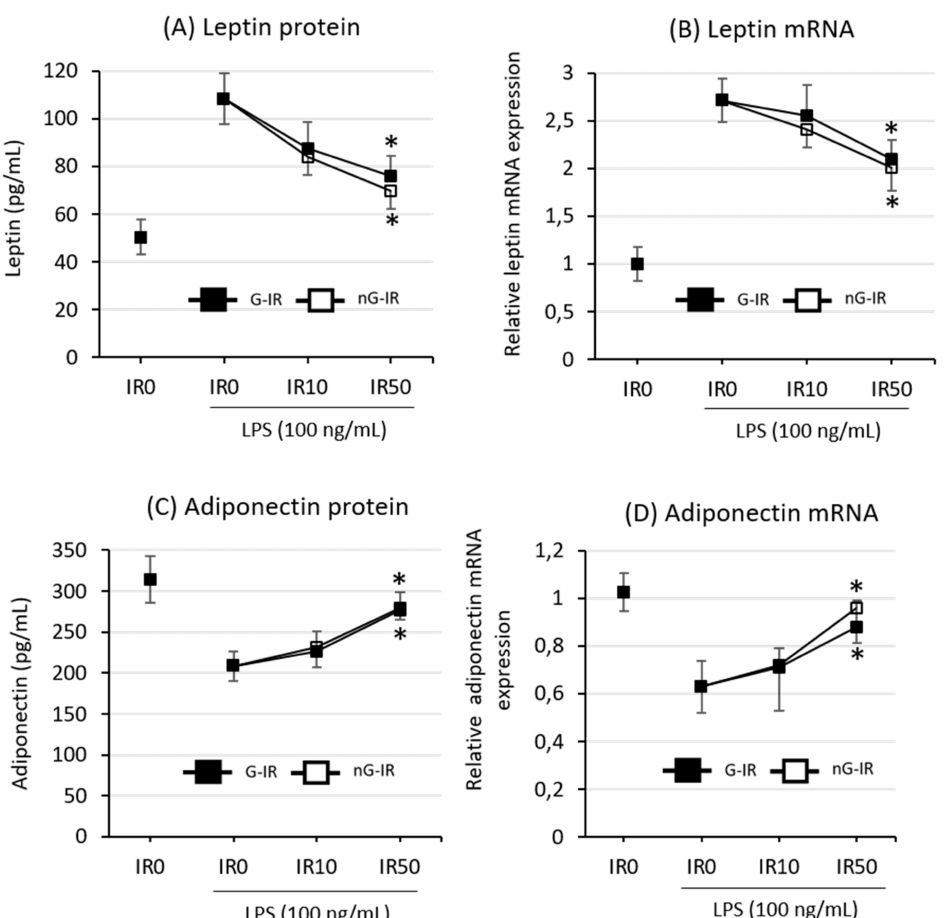
Figure 3. E ff ects of various forms of irisin (glycosylated (G-IR) or non-glycosylated (nG-IR)) on LPS-induced leptin release ( A ) or mRNA expression ( B ) and adiponectin release ( C ) or mRNA expression ( D ) by adipocyte–macrophage cocultures. Fully di ff erentiated 3T3 L1 adipocytes and RAW 264.7 macrophages were cultured in 12-well dishes with inserts (0.4- µ m pore size) for 6 h (mRNA expression, RT-PCR) or 24 h (adipokine release, ELISA tests) with or without the presence of irisin (0, 10, or 50 nM; IR0, IR10, or IR50, respectively). The results are expressed as mean + standard deviation (SD) from five independent experiments. Statistical significances ( p < 0.05) were determined with the Duncan t -test. The asterisk (*) above the bar denotes statistically significant di ff erences in protein or mRNA levels, calculated relative to the IR0